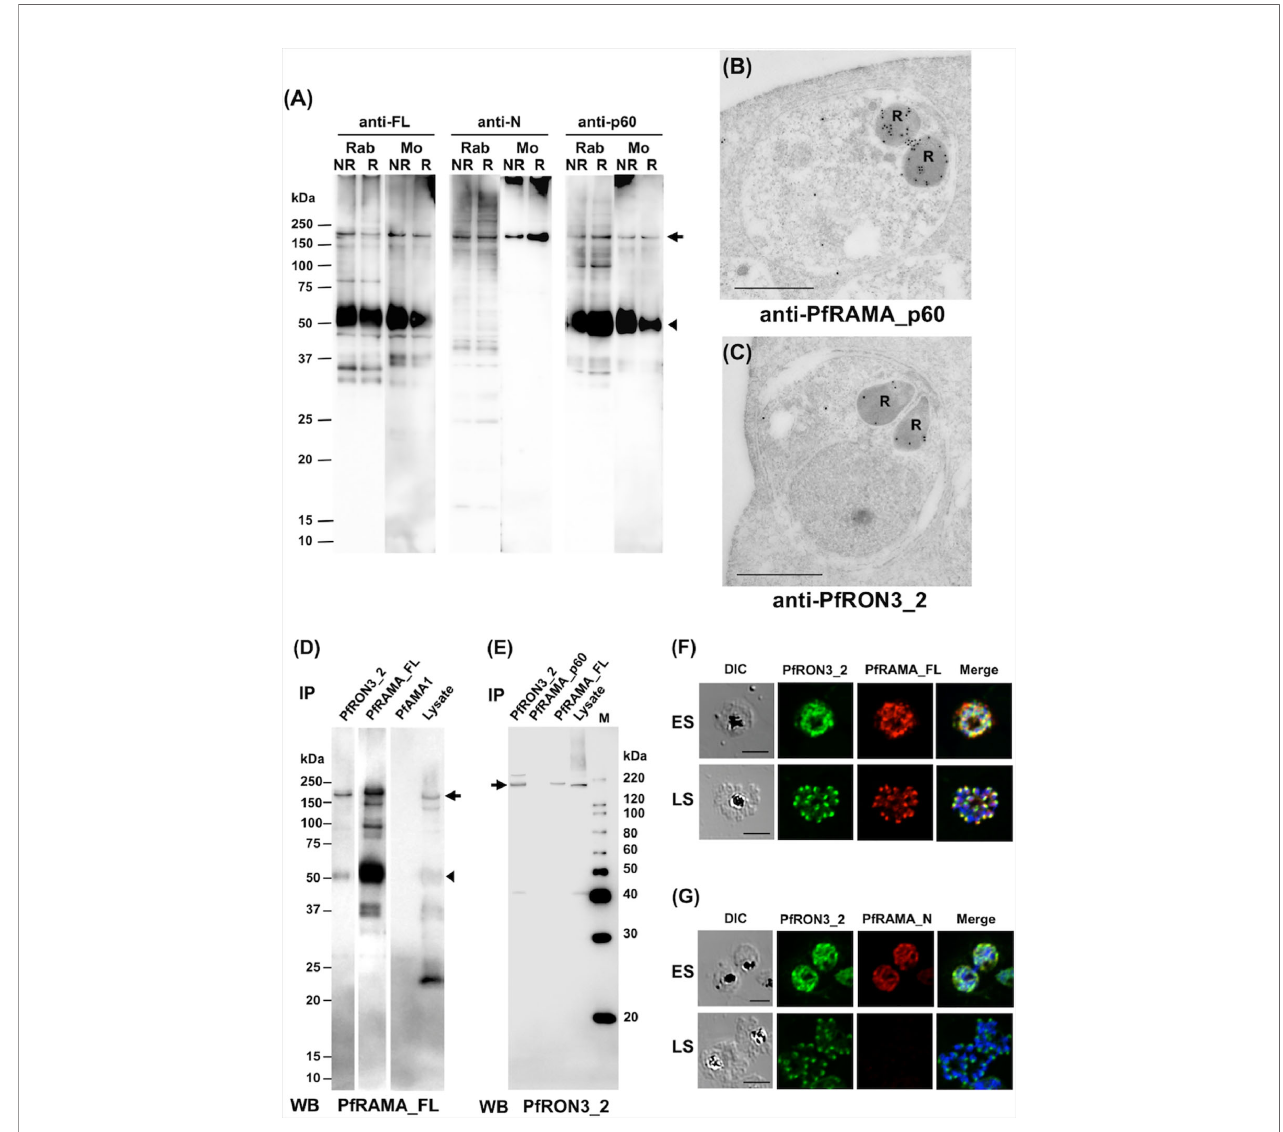
FIGURE 3 | (A) Speci fi city of anti-PfRAMA antibodies by western blot analyses. Proteins from schizont-rich parasites were extracted and separated by 12.5% SDS- PAGE under non-reducing (NR) or reducing (R) conditions. Using either anti-PfRAMA_FL, anti-PfRAMA_N, or anti-PfRAMA_p60 antibodies obtained from rabbits (Rab) and mice (Mo), a band of approximately 170 kDa (arrow) was detected as a signal of PfRAMA_FL and a 60-kDa band (arrowhead) was detected as a signal of PfRAMA_p60. (B) PfRAMA localization by IEM is shown. A representative image out of eight independent sections is shown of a merozoite in a schizont-infected erythrocyte probed with rabbit anti-PfRAMA_p60 antibody and subsequently with a secondary antibody conjugated with gold particles. The black dots indicate signals from gold particles localized in the rhoptry bulb. R, rhoptry. (C) PfRON3 localization shown by IEM. A representative image out of 16 independent sections is shown of a merozoite in a schizont-infected erythrocyte probed with rabbit anti-PfRON3_2 antibody and subsequently with a secondary antibody conjugated with gold particles. The black dots indicate signals from gold particles localized in the rhoptry bulb. R, rhoptry. Bars = 500 nm. (D) PfRAMA_FL interacts with PfRON3. NP-40 extracts of schizont-rich parasites (Lysate) were immunoprecipitated (IP) with rabbit sera against PfRON3 (anti-PfRON3_2), PfRAMA (anti-PfRAMA_FL), or PfAMA1 (anti-PfAMA1), then stained with mouse antisera (WB) against PfRAMA_FL. This panel is a representative result of two independent experiments. (E) PfRAMA_FL but not PfRAMA_p60 interacts with PfRON3. NP-40 extracts of schizont-rich parasites (Lysate) were immunoprecipitated (IP) with rabbit sera against PfRON3 (anti-PfRON3_2), PfRAMA (anti-PfRAMA_p60), or PfRAMA (anti-PfRAMA_FL), then stained with mouse antisera (WB) against PfRON3_2. M, molecular weight marker. This panel is a representative result of two independent experiments. (F) Co-localization of PfRON3 and PfRAMA. Immature early schizont (ES) or mature late schizont (LS) stage parasites were dual-labeled with rabbit antibodies against PfRON3_2 and mouse antibodies against PfRAMA_FL. Nuclei were visualized with DAPI in merged images shown in the right most panels. DIC, differential interference contrast microscopy. Merge, the image created by merging the IFA and nuclear-staining images. Bars represent 5 m m. (G) Co-localization of PfRON3 and PfRAMA. Immature early schizont (ES) or mature late schizont (LS) stage parasites were dual-labeled with rabbit antibodies against PfRON3_2 and mouse antibodies against PfRAMA_N. Nuclei were visualized with DAPI in merged images shown in the right most panels. DIC, differential interference contrast microscopy. Merge, the image created by merging the IFA and nuclear-staining images. Bars represent 5 m